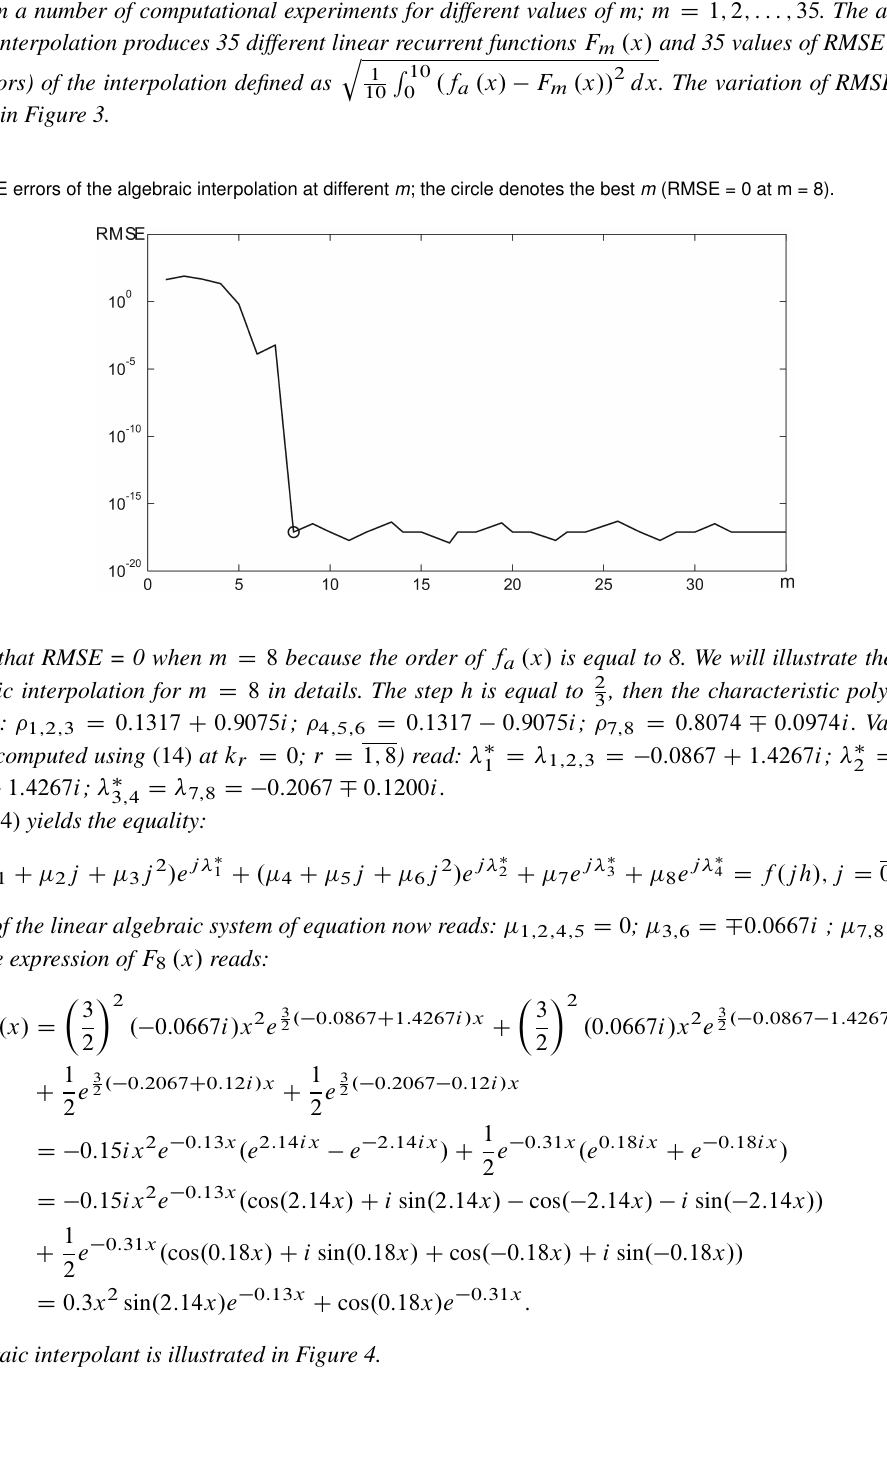
Fig. 3. RMSE errors of the algebraic interpolation at different m ; the circle denotes the best m (RMSE = 0 at m = 8).